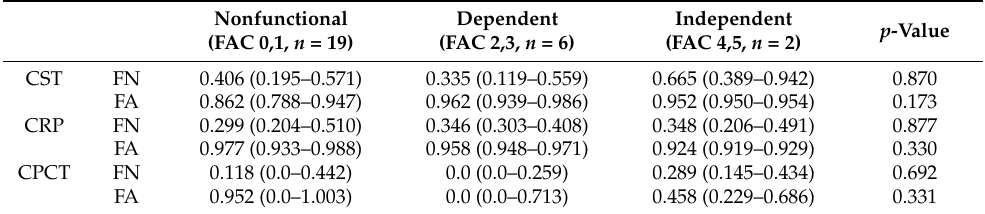
Table 3. FN and FA values of CST, CRP, CPCT by group according to the independence of ambulation